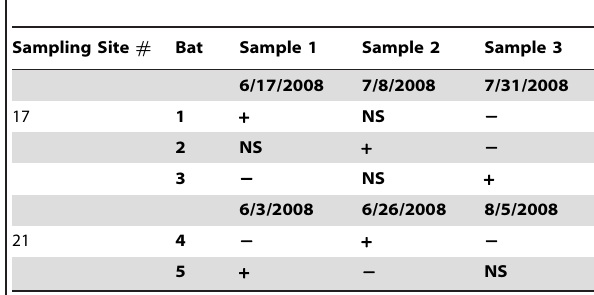
Table 3. Detection of CoV RNA in 16 individually tagged big brown bats that were captured and sampled on multiple dates during the summer of